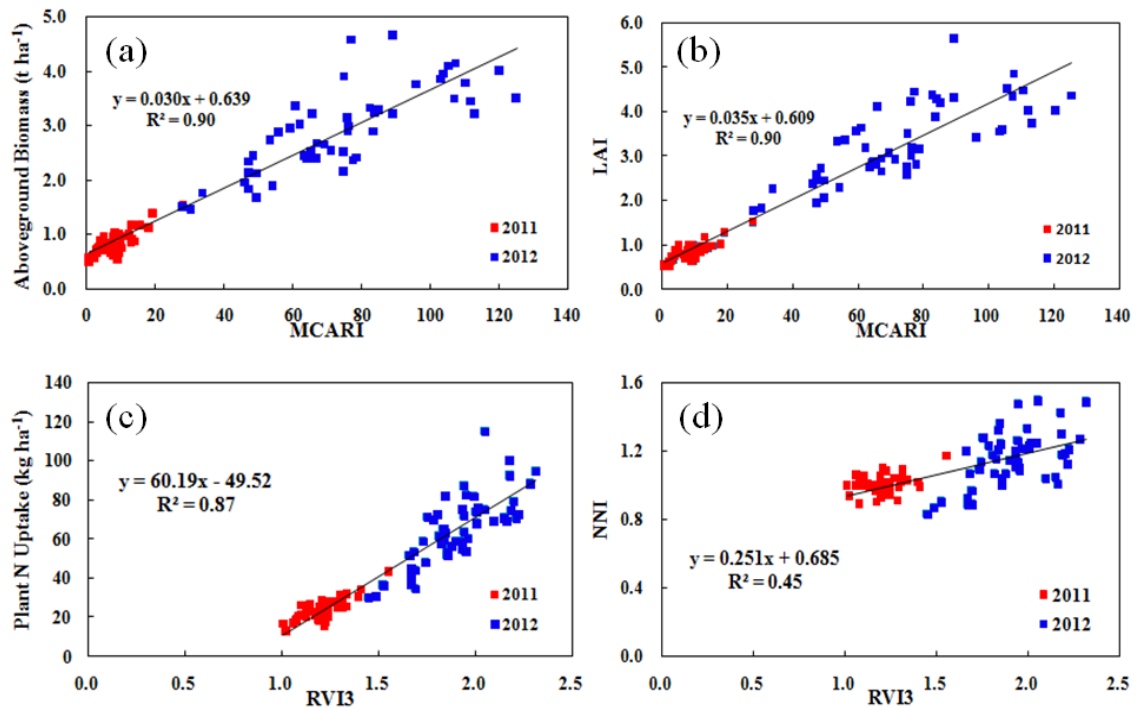
Figure 1. Selected VI regression vs. rice aboveground biomass ( a ) LAI; ( b ) plant N uptake (PNU); ( c ) and NNI; ( d ) Heilongjiang Province, China,